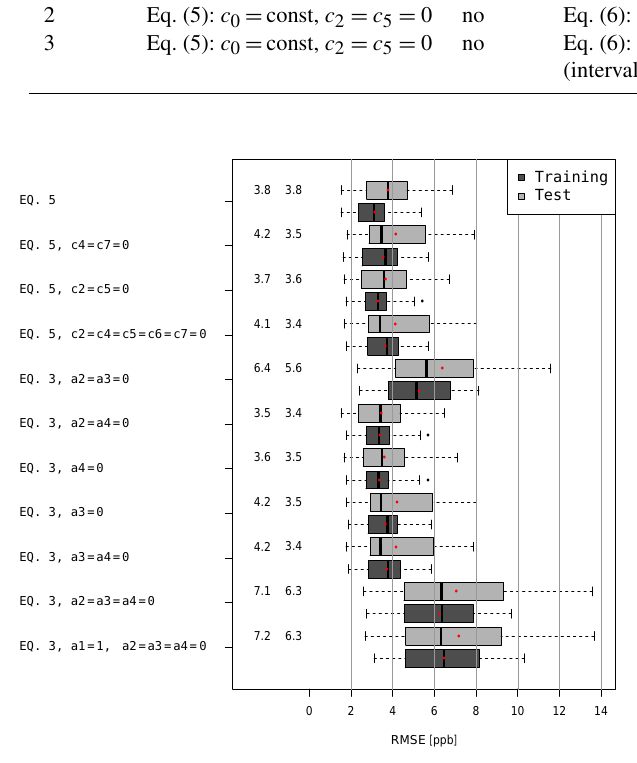
Figure 4. Results for the O 3 sensors analogue to Fig. 3a. Negative O 3 values set to zero for RMSE